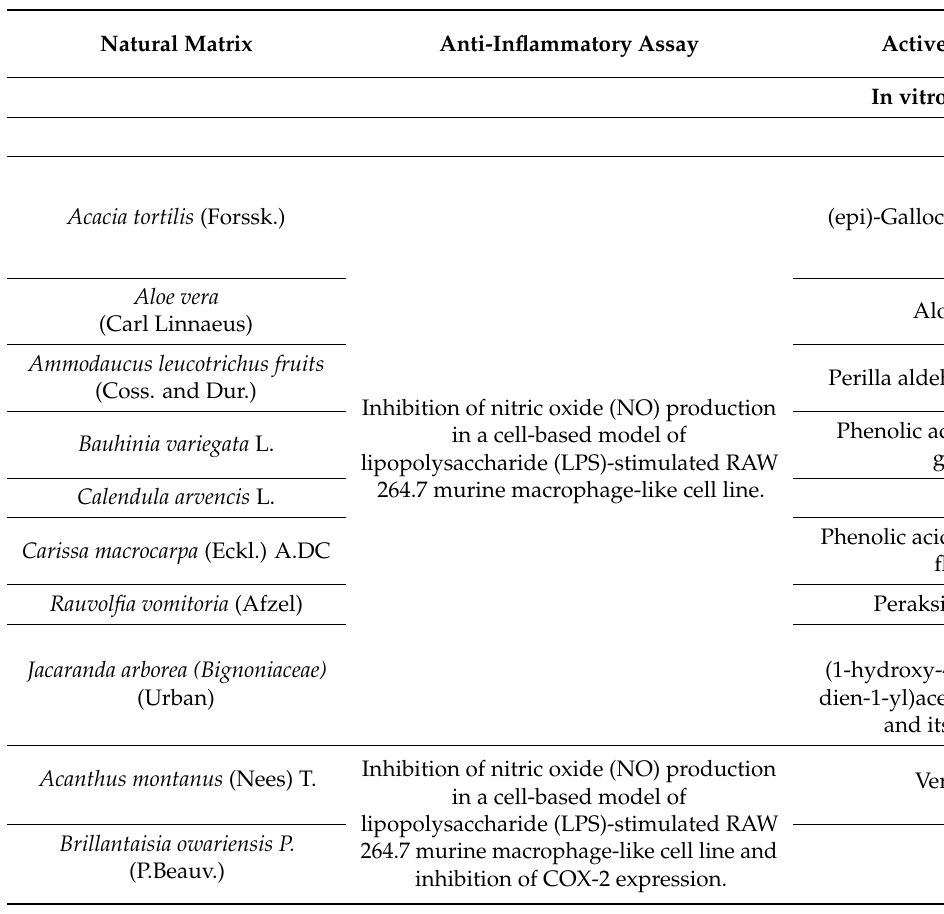
Table 3. In vitro and in vivo anti-inflammatory activities of natural